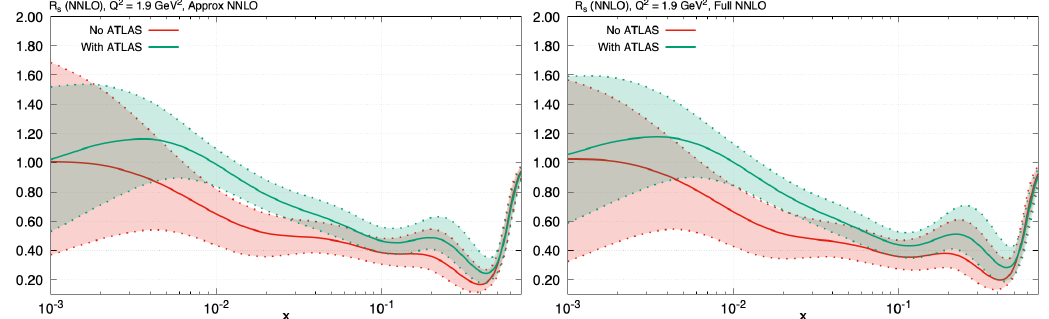
Figure 1: The ratio of strange quarks to light quarks in fits without (left) and with (right) the full NNLO